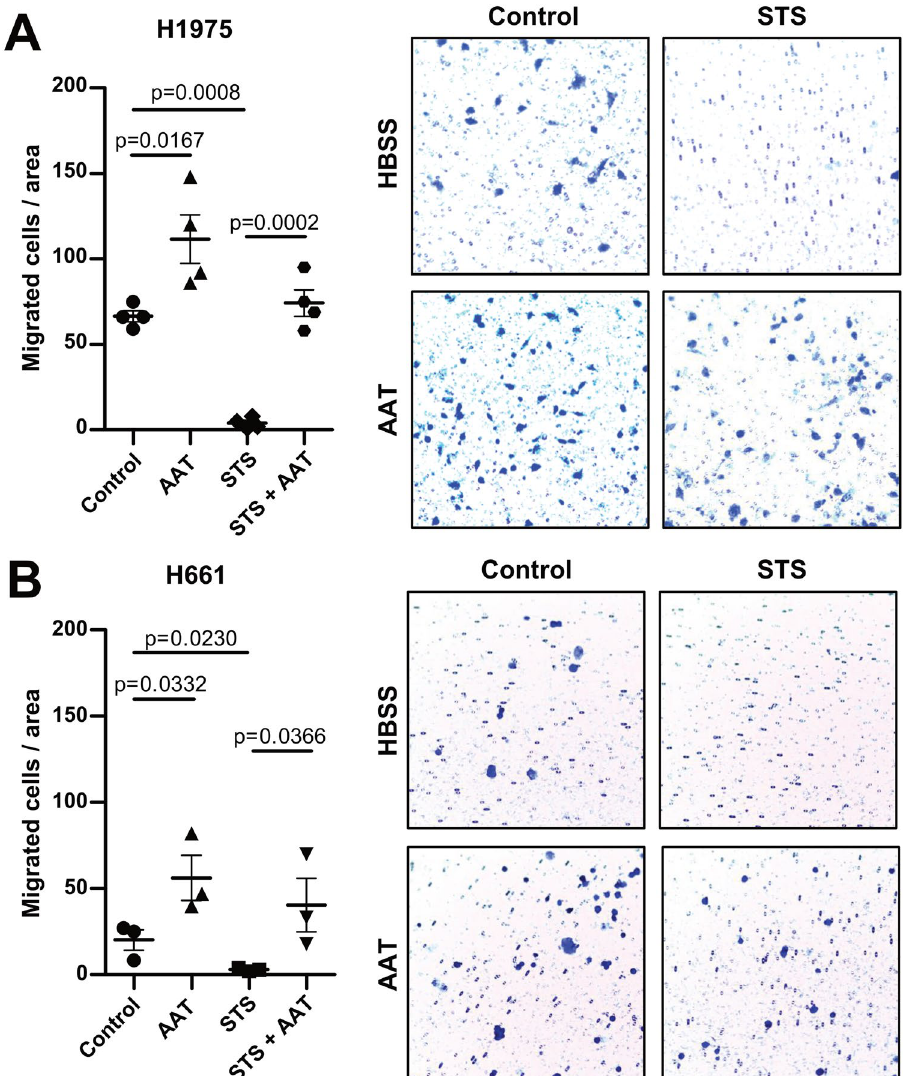
Figure 8. Exogenously added AAT prevents STS-induced loss of cancer cell migration. H1975 and H661 cells migration was studied within 3 h with addition to the medium HBSS (controls), 50 nM STS or 1.5 mg/ml AAT separately or in combination. The migrated cells were stained with 0.1% crystal violet. For quantification, the stained cells were counted under a microscope (Leica DM750) with 10x objective from six areas. ( A ) (H1975 cells), the graph indicates data from four independent experiments as mean (SD) and the individual values. ( B ) (H661 cells), the graph shows data from three independent experiments as mean (SD) and the individual values. p < 0.05 was considered as